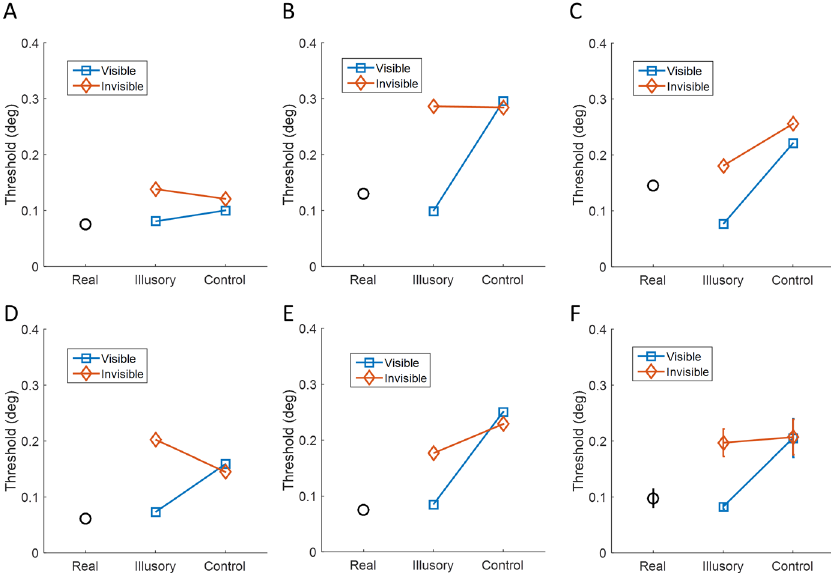
Fig 5. Results of experiment 2. Spatial discrimination thresholds per condition (real luminance vs illusory vs control) on a dot localization task while participants were presented with visible (blue squares), invisible (orange diamonds), or real luminance stimuli (black circles). A-E) Plots for the five individual participants. F) Thresholds averaged across participants ± 1 standard error of the